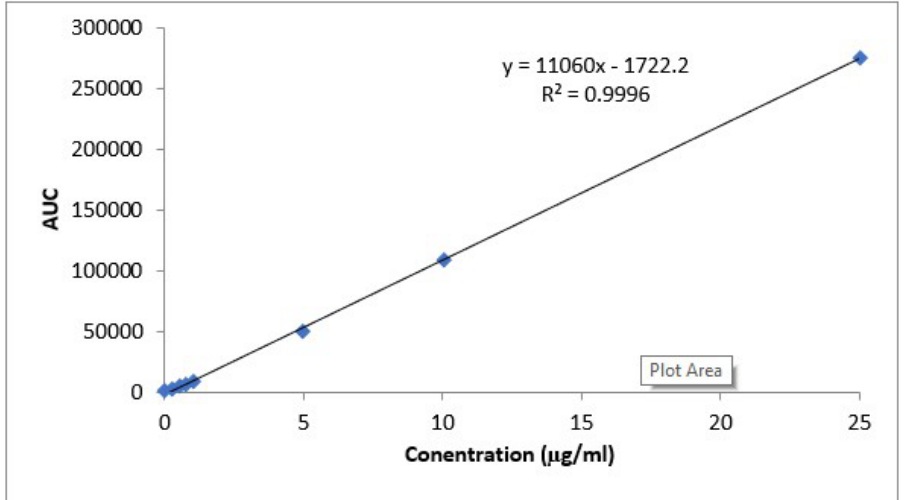
Figure 2. Calibration curve of determination of CLZ in rat plasma using HPLC method.